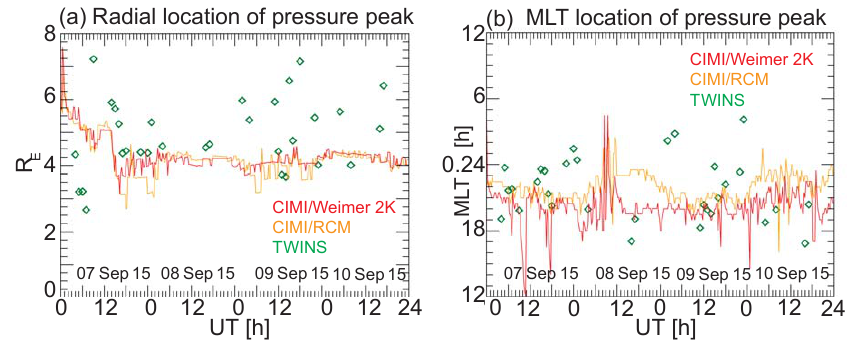
Figure 2. Plot of the ion equatorial pressure peak as a function of time during the 4-day period 7–10 September 2015. (a) The radial location and (b) the MLT location. The green triangles mark the locations obtained from the TWINS ENA images, the red line from the CIMI/Weimer simulations, and the orange line from the CIMI/RCM simulations.